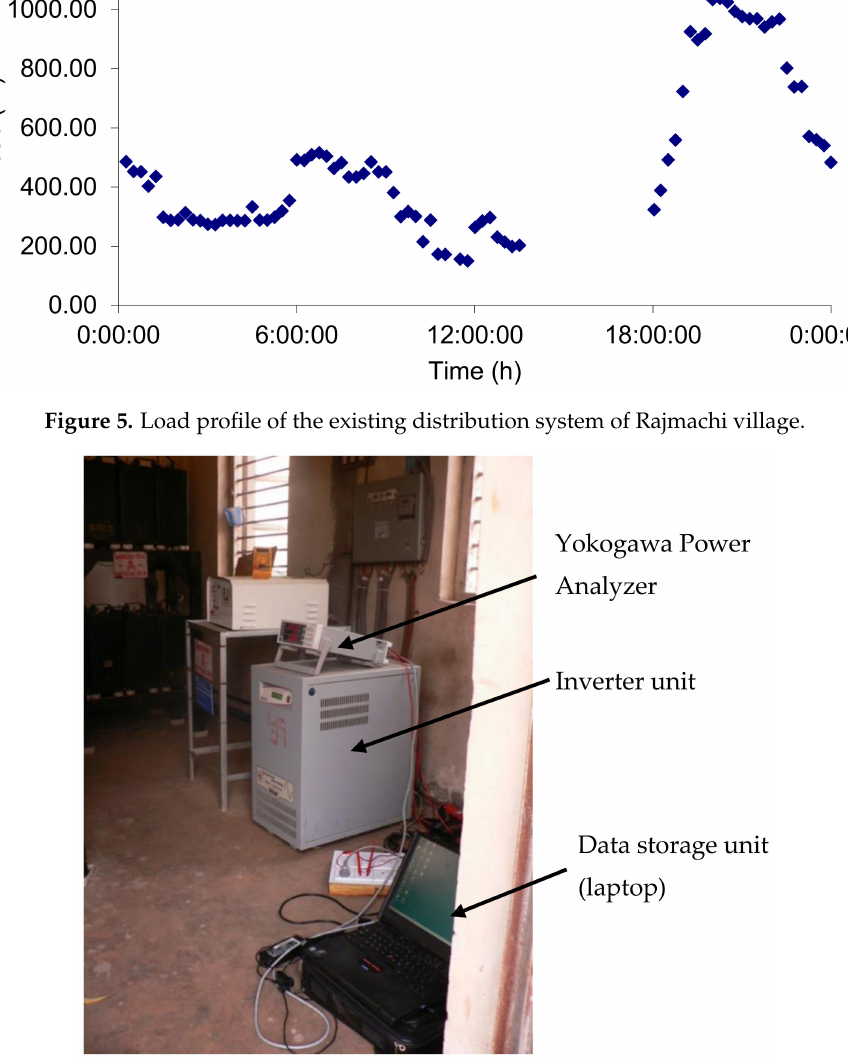
Figure 6. Experimental setup to analyse the load and voltage